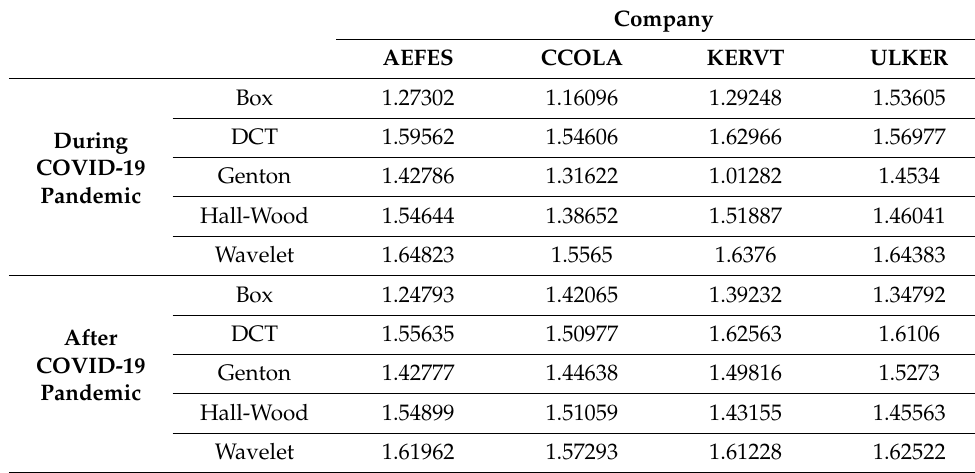
Table A5. Fractal dimensions for the food, beverage and tobacco sector.